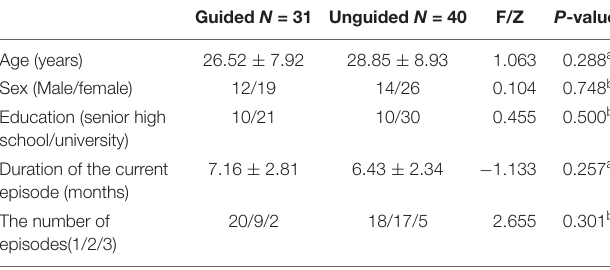
TABLE 3 | Distribution of phenotypes in two